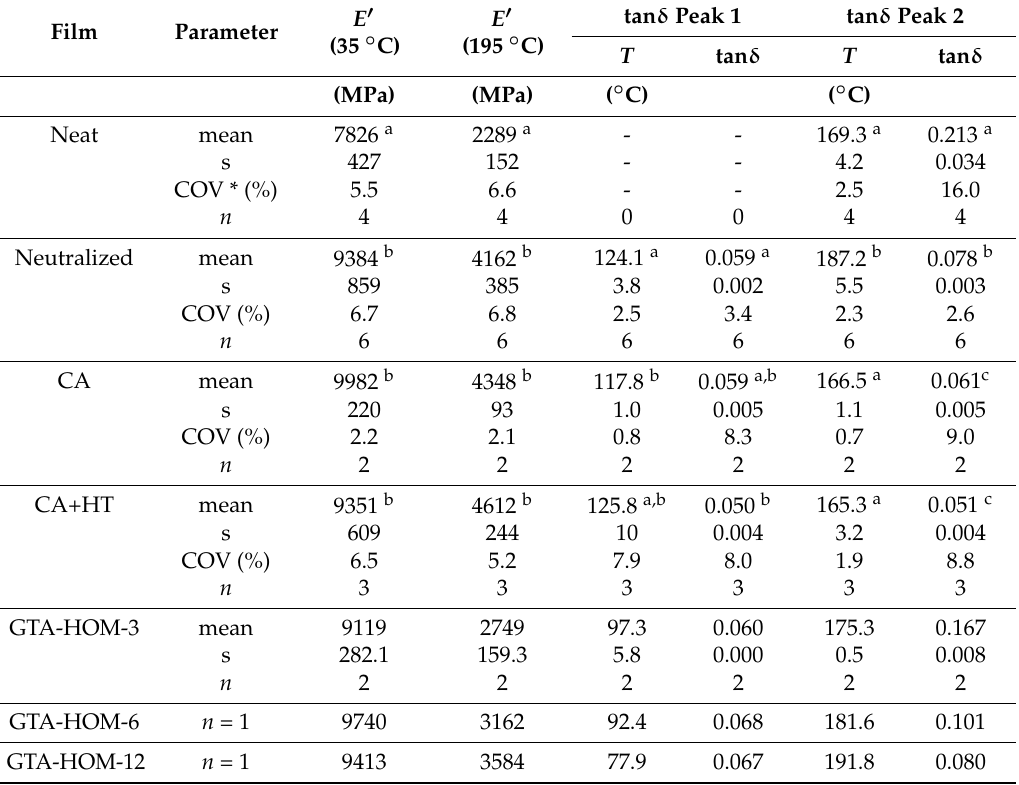
Table 4. Characteristics of DMA curves for Preheated Specimens (see Table 2 for film code names).